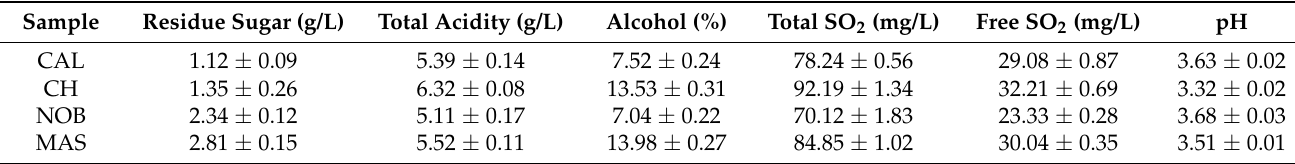
Table 1. Physicochemical indices of